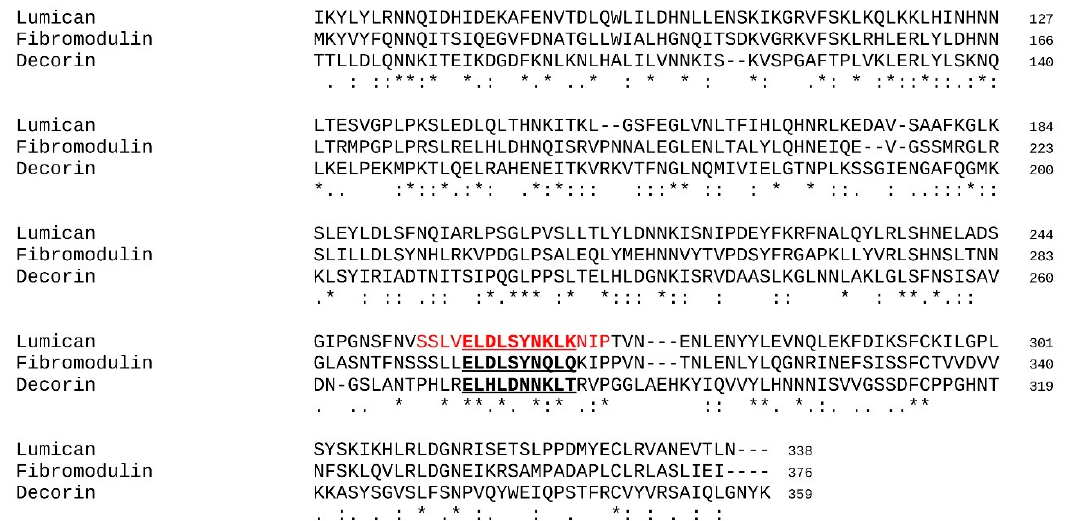
Figure 1. Sequence alignment of lumican, decorin and fibromodulin. The lumcorin peptide is evidenced in red in the lumican amino acid (aa) sequence and the L9M peptide is highlighted in red bold underlined characters. The equivalent D9M and F9M peptides in decorin and fibromodulin aa sequences are highlighted in bold underlined characters, respectively. Alignment ruler: *, identity; homology; similarity.